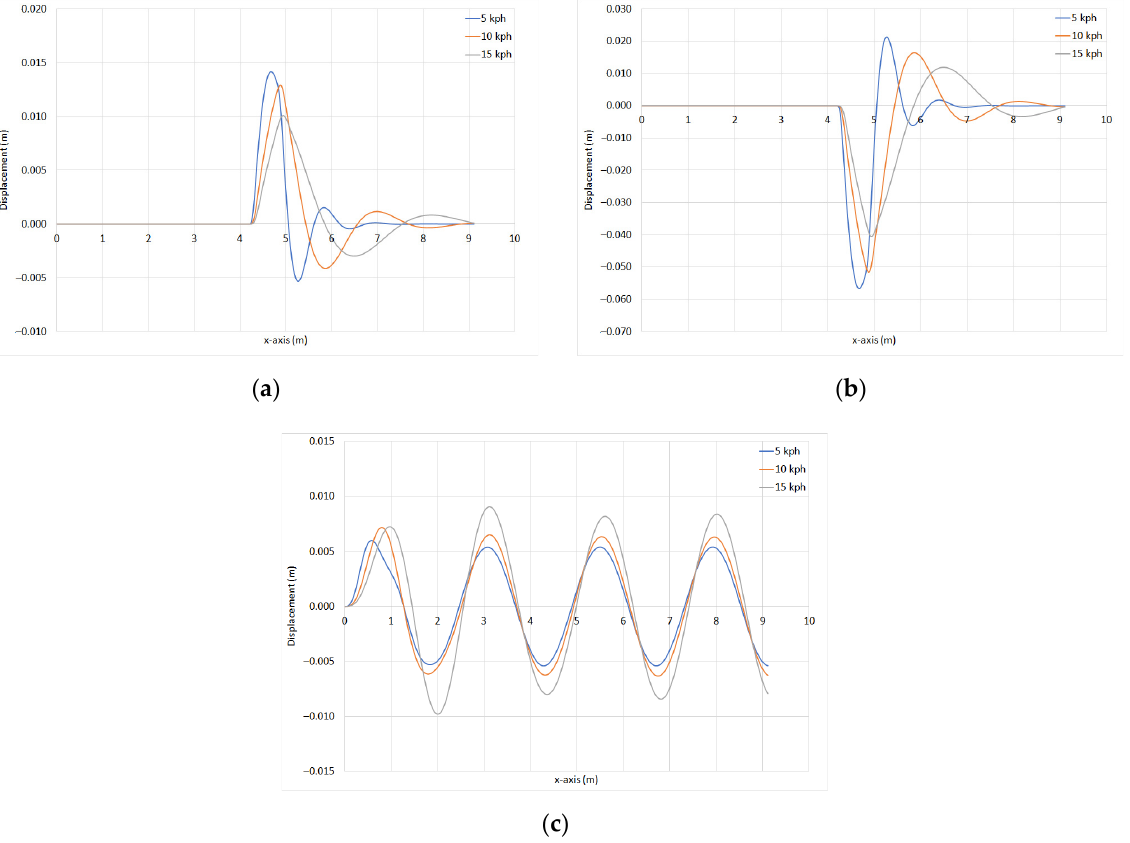
Figure 9. The vertical displacement of the sprung mass versus the position of the vehicle on the x-axis for the ( a ) bump, ( b ) pothole and ( c ) periodic excitation. The same results are presented for road profiles of Classes A, C and E in Figure 10.